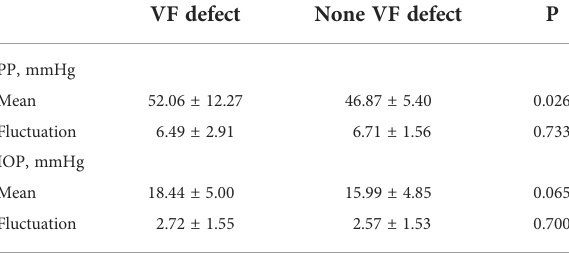
TABLE 2 Blood pressure and IOP information in all TAO